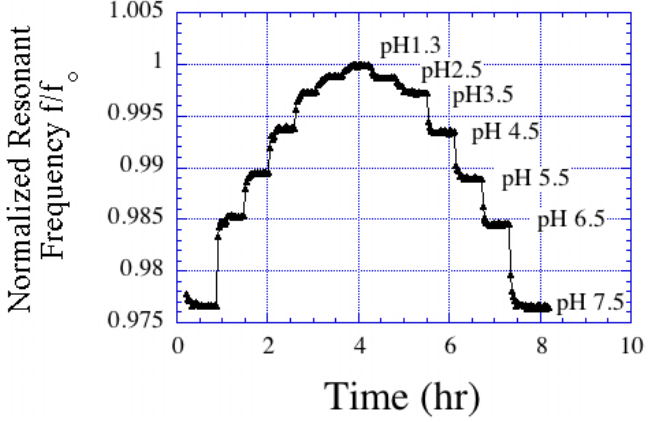
Figure 23. Calibration curve for a pH sensor. The frequency response is normalized to the measured value at pH = 1.3. Reprinted with permission from